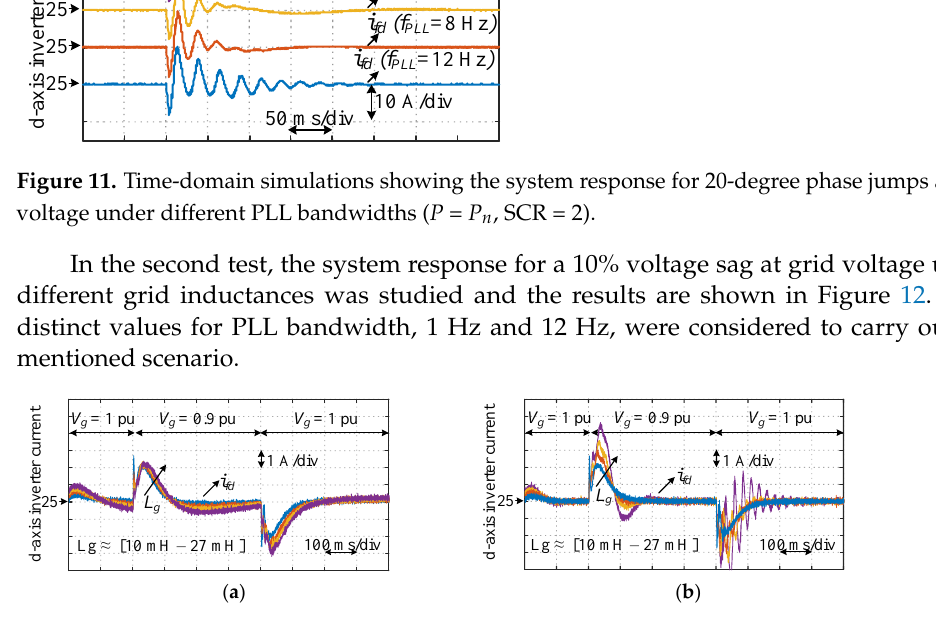
16 of 23 Table 5. Participation factor analysis of critical modes for different grid SCR and PLL bandwidths ( P = P n ). SCR